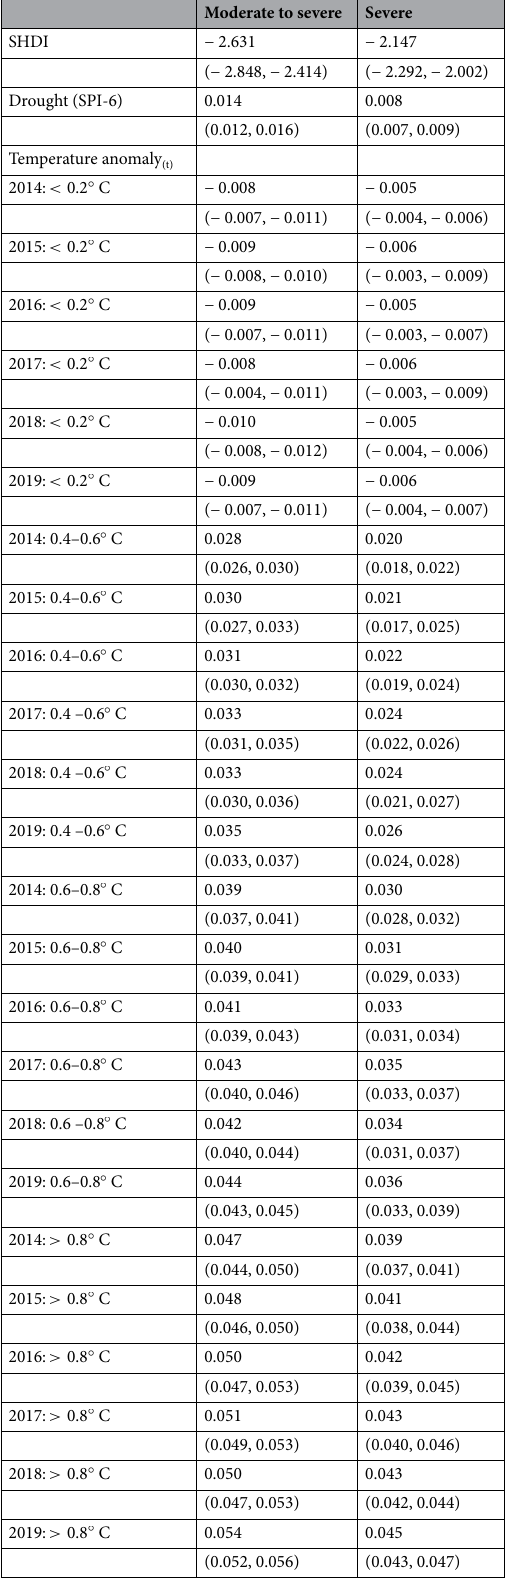
Table 2. Time-varying regressions with bins of monthly temperature anomalies (0.2–0.4 ◦ C is the reference